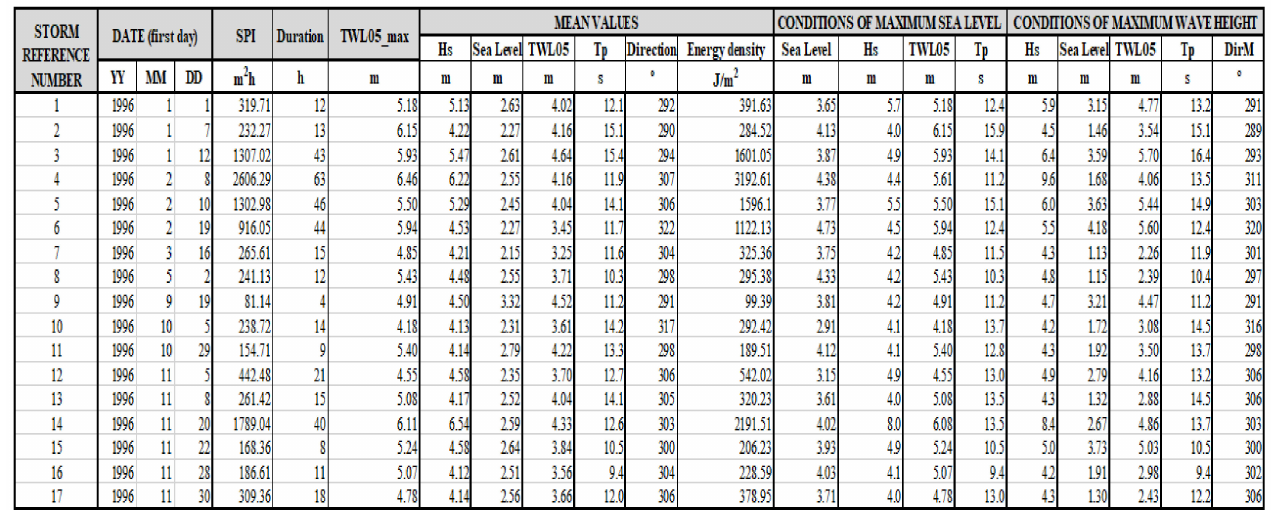
Figure 3. Extract from storm inventory. Data of some wave storms (in chronological order) out of the total of 346 in the